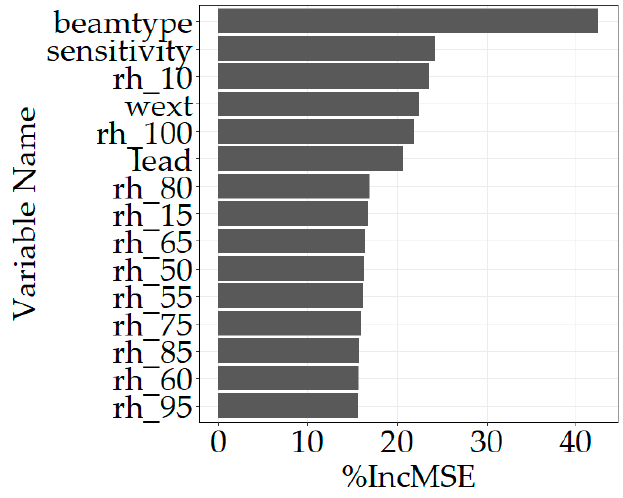
Figure 9. Importance of RF variables (fifteen most important) using mean decrease accuracy (%IncMSE).